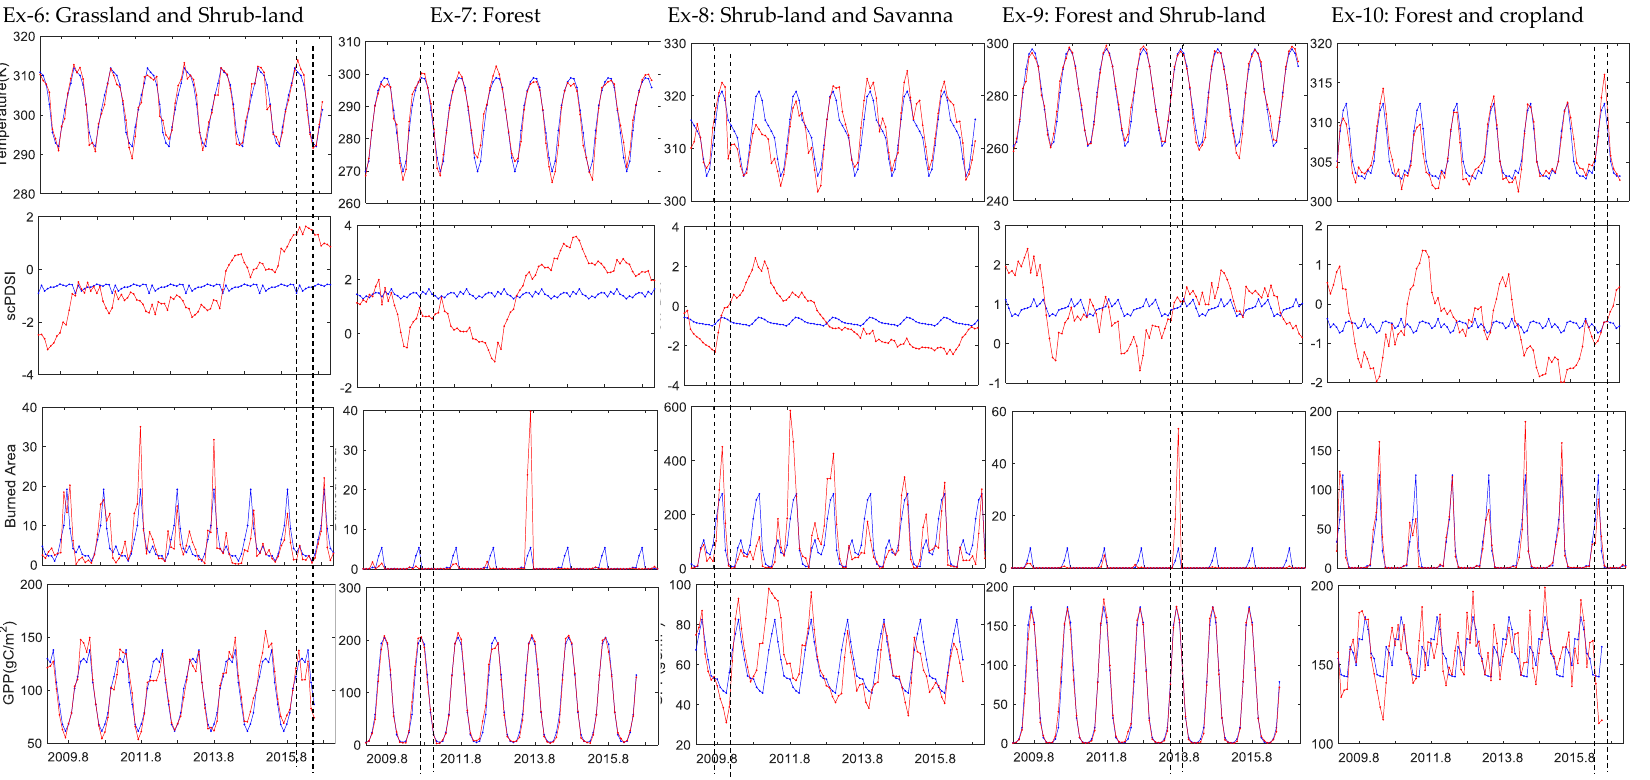
Figure 5. Monthly data, from 2009 to 2016, of parameters including surface skin temperature (Temperature), scPDSI, BA and GPP over detected XCO 2 extreme units 6~10. Red line is the observed dataset and the blue line is seasonal mean data over the 8 years, calculated using the observed data. Time within black dashed lines indicates each extreme high XCO 2 unit.